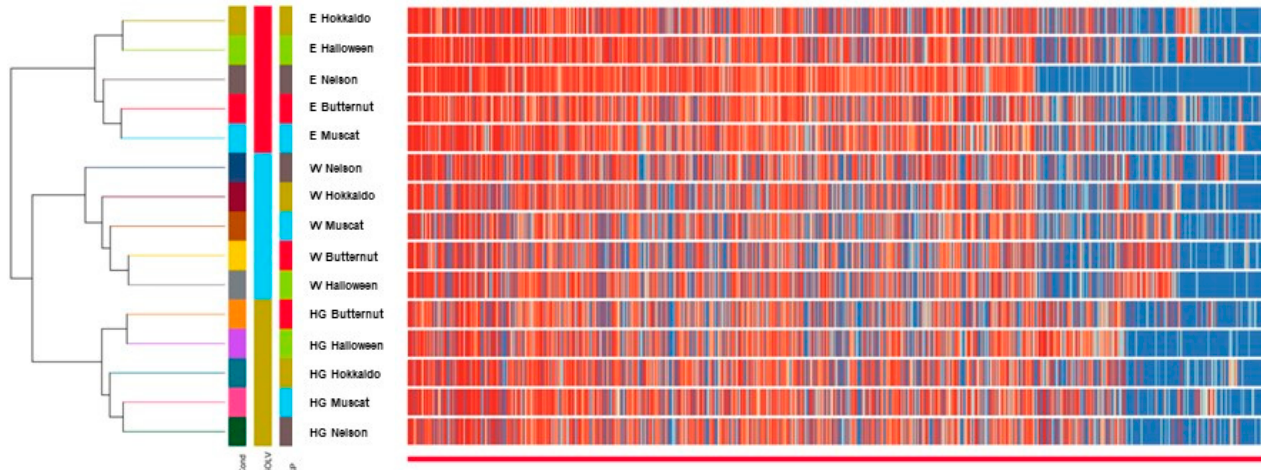
Figure 4. Dendrogram showing the results of the cluster analysis. Explanation of the abbreviations: aqueous extracts (W), hydroglycolic extracts (HG), hydroethanolic extracts (E).